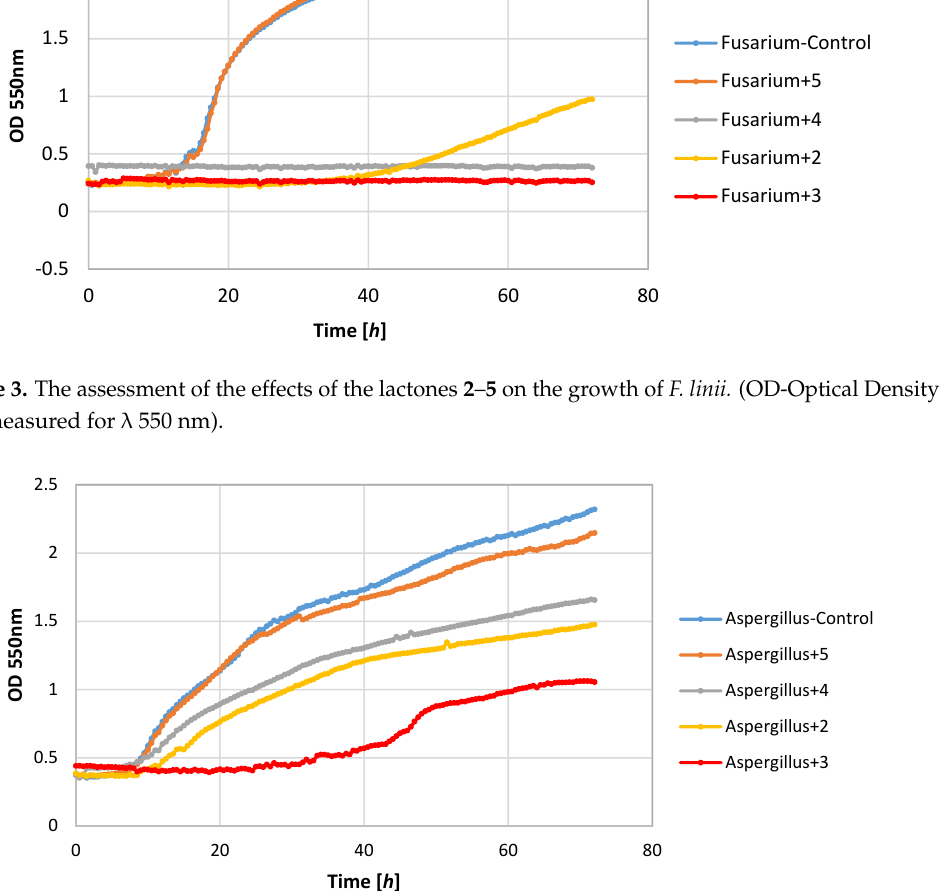
Figure 5. The assessment of the effects of the lactones 2 – 5 on the growth of E. coli. (OD ‐ Optical Density was measured for λ 550 nm).